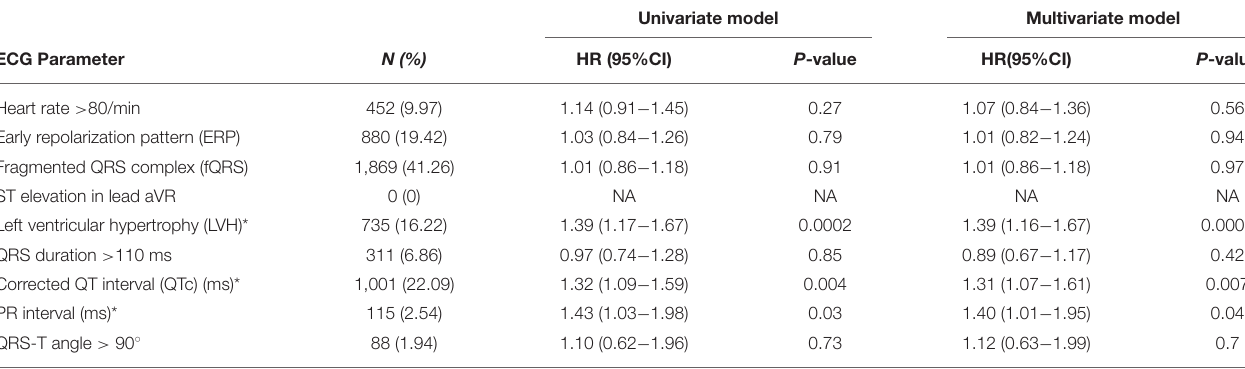
TABLE 1 | Association between ECG parameters and all-cause death. # ( N = 4,530).